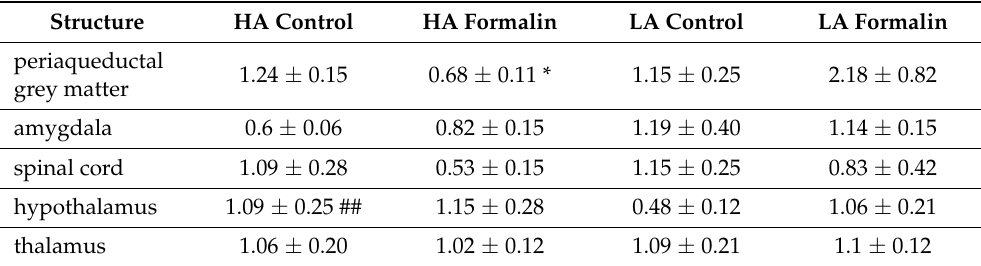
Table 4. Delta opioid receptor 1 (Oprd1) mRNA levels in HA and LA mice in the interphase of the formalin test. Mice were injected with 5% formalin (in PBS) into the dorsal aspect of the hind paw ( n = 4–6). Samples were harvested 15 min post-formalin. Results were analysed within each line with two-way ANOVA followed by Bonferroni’s post-hoc test. Statistical significance was depicted as follows: * p ≤ 0.05 (vs. control); ## p ≤ 0.01 (vs. control LA).